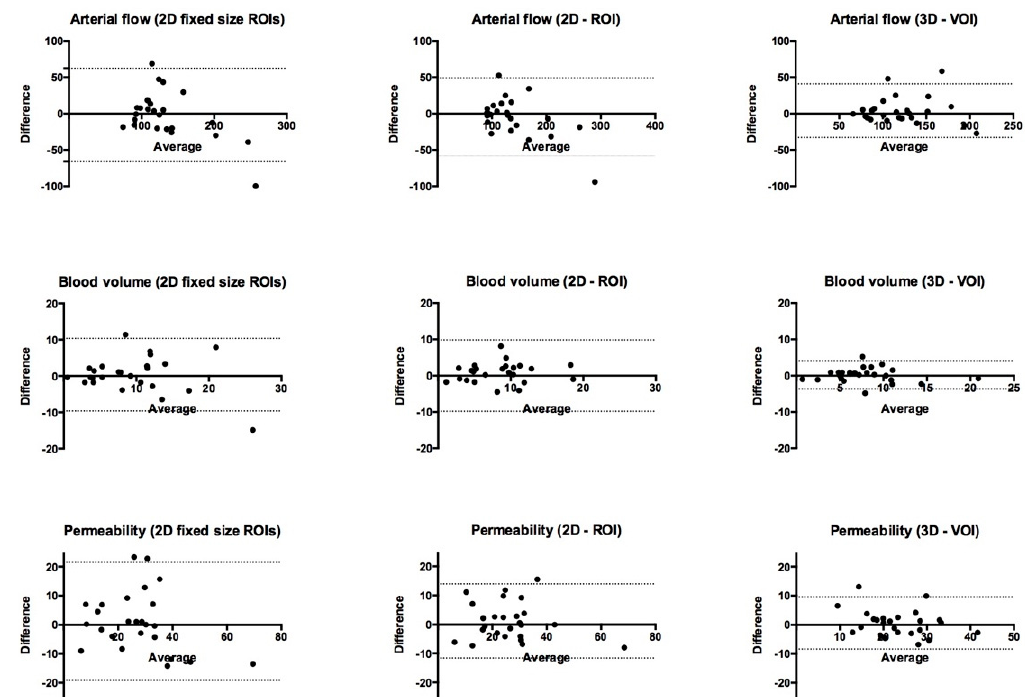
Figure 2. Bland–Altman plots for interobserver variation for arterial flow, blood volume and permeability with the three methods: (I) average between four ROIs of fixed size, (II) 2D-ROI around tumor border, and (III) 3D-VOI of the entire tumor volume. Narrowing of 95% limits of agreement for all three perfusion measures indicate better reproducibility for 3D-VOI compared to 2D analysis.